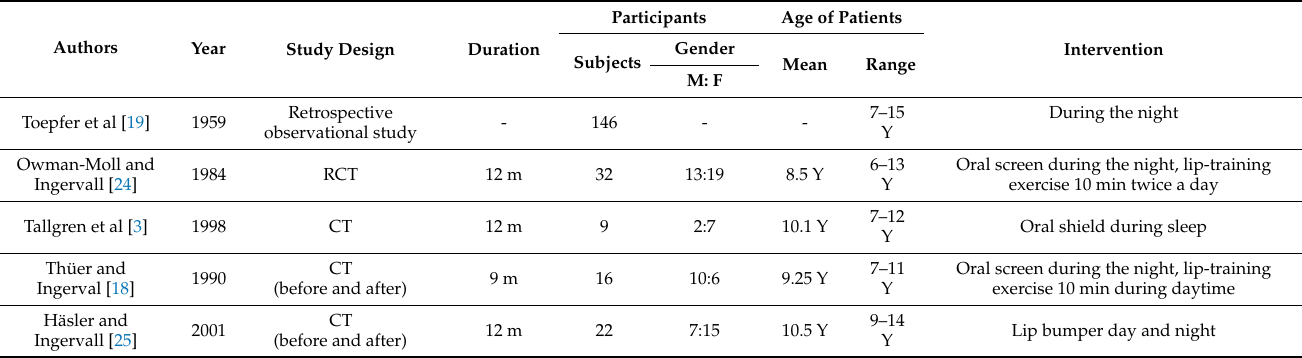
Table 2. Characteristics of included studies in scoping review.